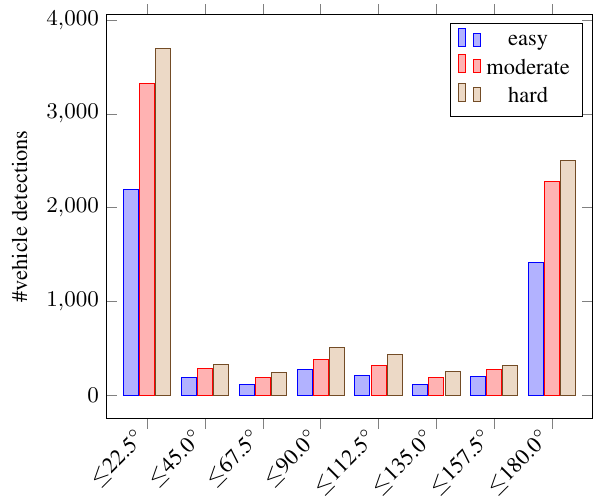
Figure 4. Histogram of absolute differences between model orientation and reference object